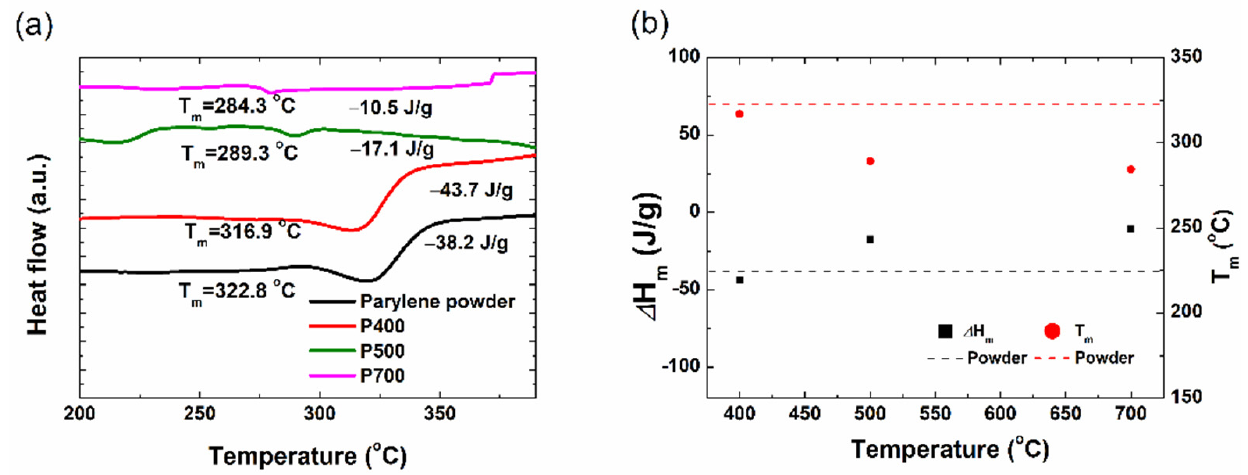
Figure 4. ( a ) DSC curves of the parylene powder; P400, P500, and P700 parylene films, ( b ) onset and peak melting temperatures.